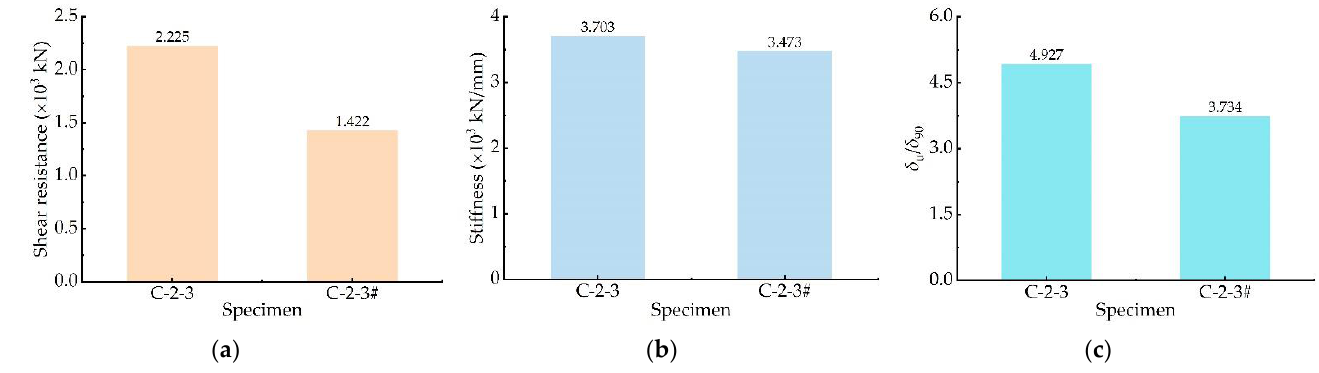
Figure 13. Influence of end-bearing mode: ( a ) shear resistance; ( b ) shear stiffness; ( c ) ductility.